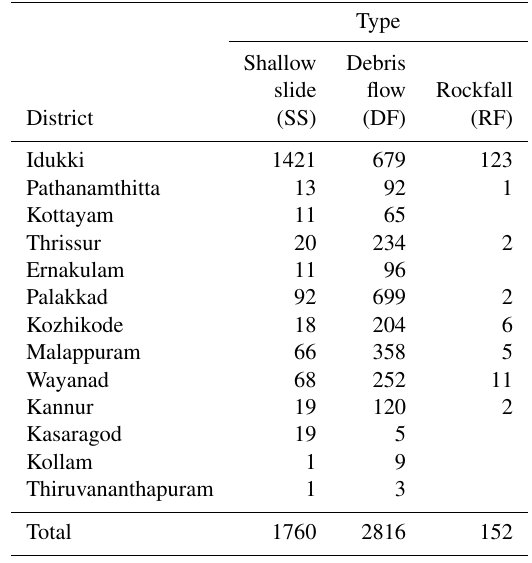
Table 2. The number of landslides classified by types in each dis- trict in Kerala.